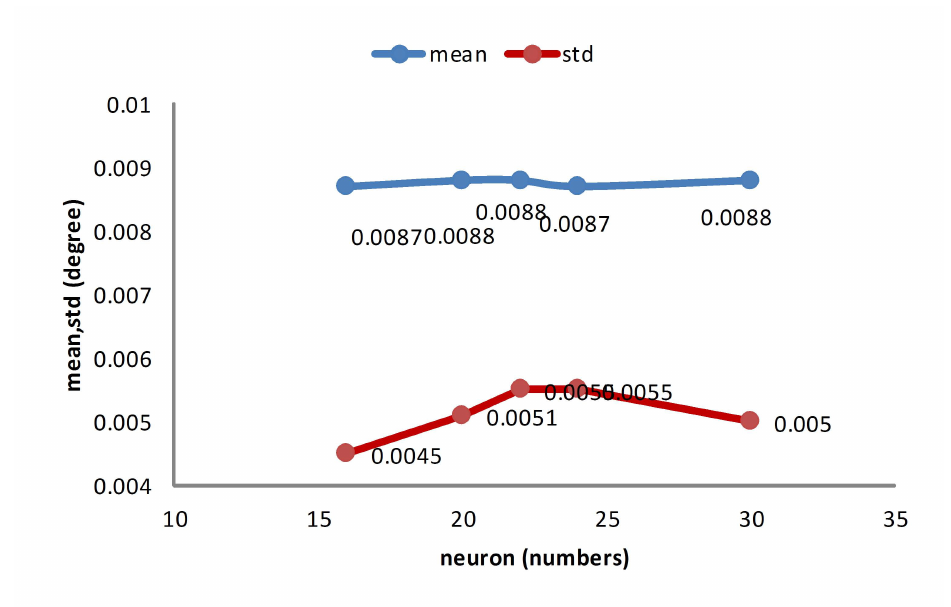
Figure 14. The features of post-compensated